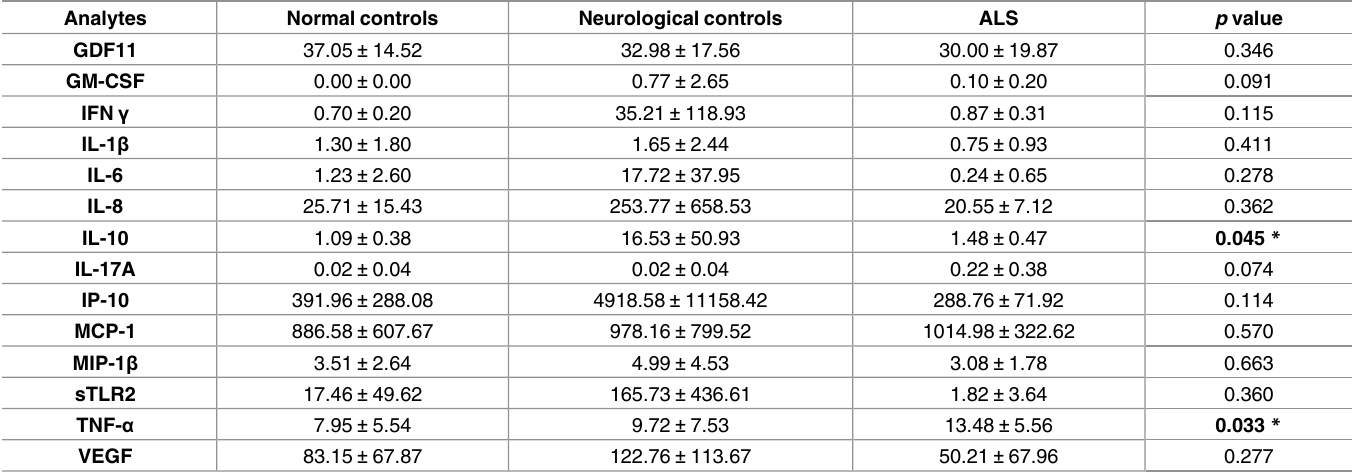
Table 2. Levels of analytes (pg/ml) measuredin the CSF of normal controls (n = 13), neurological controls (n = 12), and patients with ALS (n =